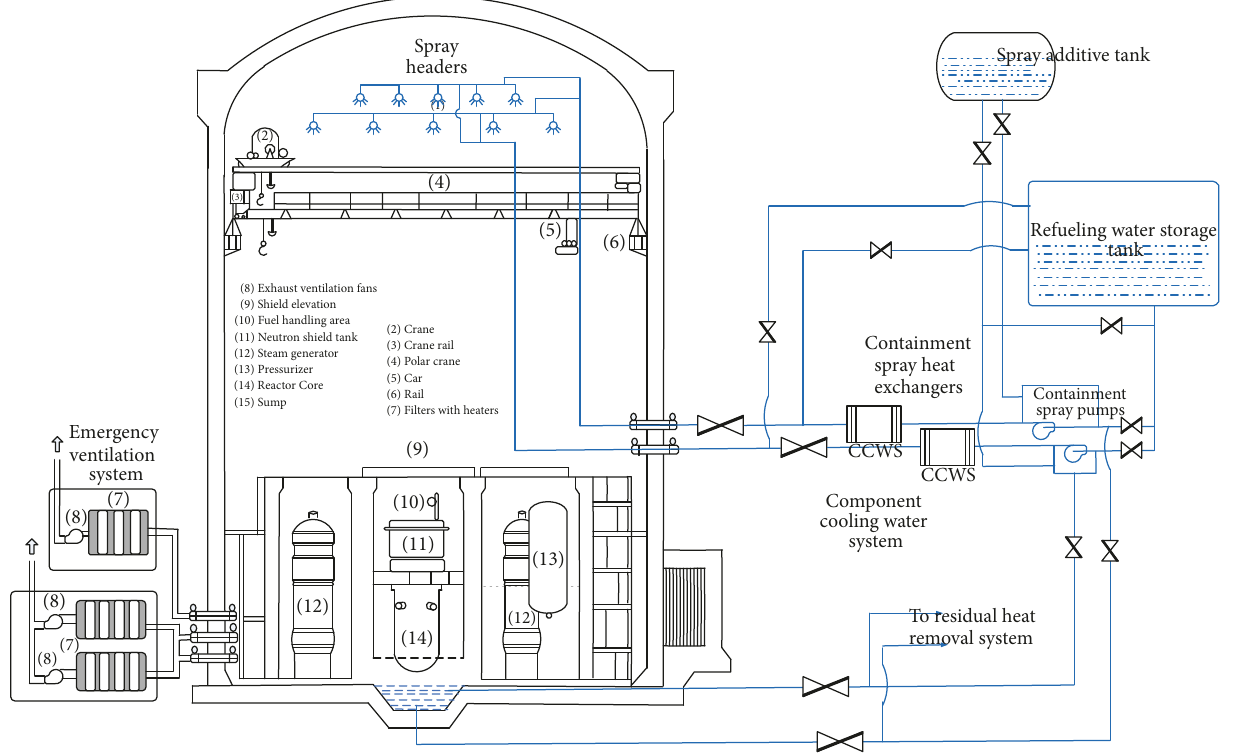
Table 2: Consequences and events in LOCA for simulation. LOCA event Time (s) Large break in the cold leg 0s Reactor trip 2 s Start of spray system LIPS activation ≅ 260 s Release of fission product to primary circuit Uncovered core ≅ 1800s PRV failure ≅ 3700 s